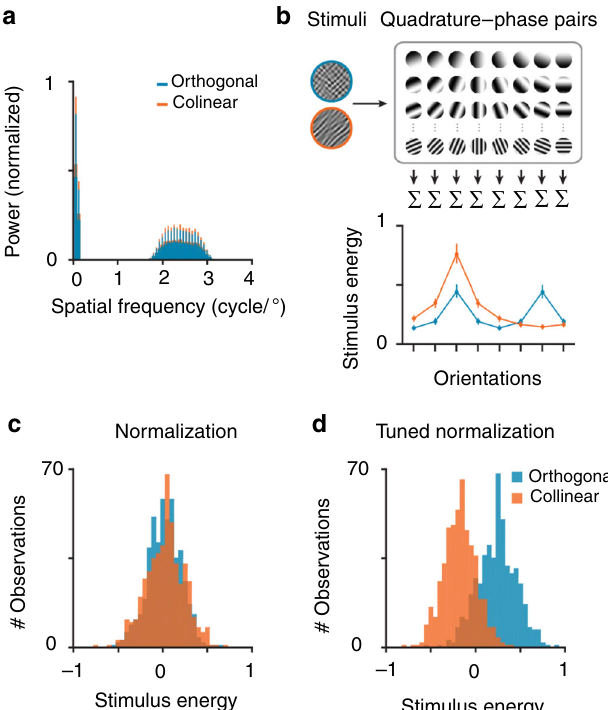
Fig. 2 Image statistics between collinear and orthogonal stimuli did not differ. a Average normalized power obtained with a 2D Fourier transform of 500 images within each stimulus con fi guration (collapsed across phase). Error bars denote ± 1 S.E.M. b Energy detector model. Stimuli were convolved with a set of Gabor fi lters across space (centered on every pixel of the image), phase (two phases to create a quadrature pair), spatial frequency (36 scales, ranged between 0.5 – 4 cycles/°), and orientations (eight orientation channels). The quadrature-phase pairs were squared, response at the eight orientation channels for each image, see Methods.